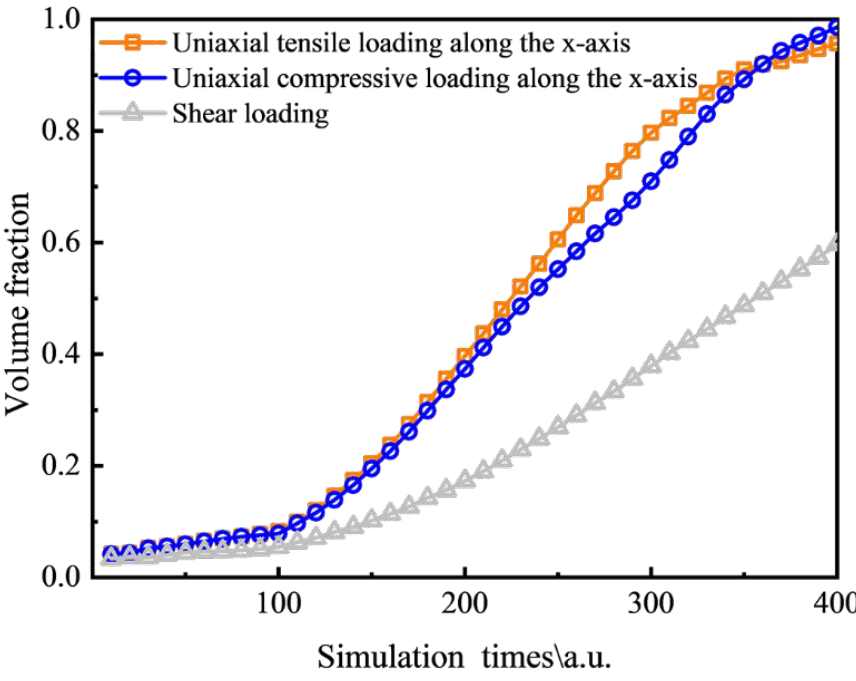
Figure 4. The kinetic curves of martensite transformation for different loading modes.